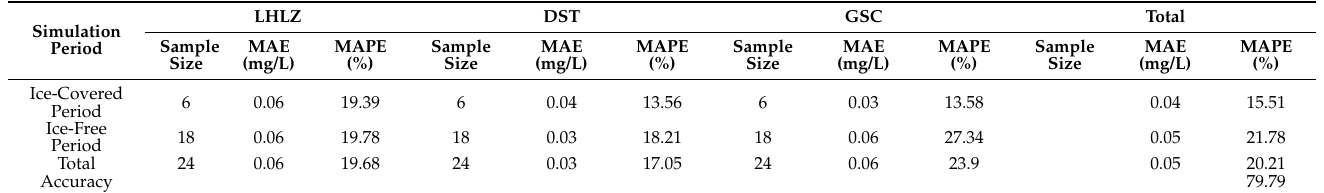
Table 3. Statistical results for NH 3 N between simulated and observed values in Jingpo Lake